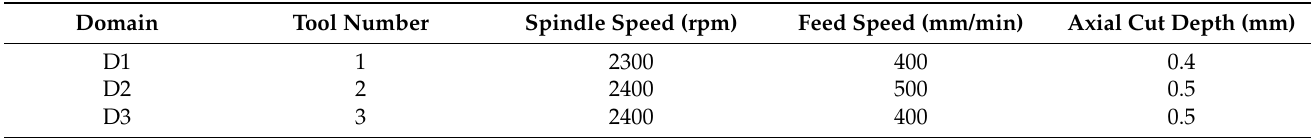
Table 2. Experimental parameters.